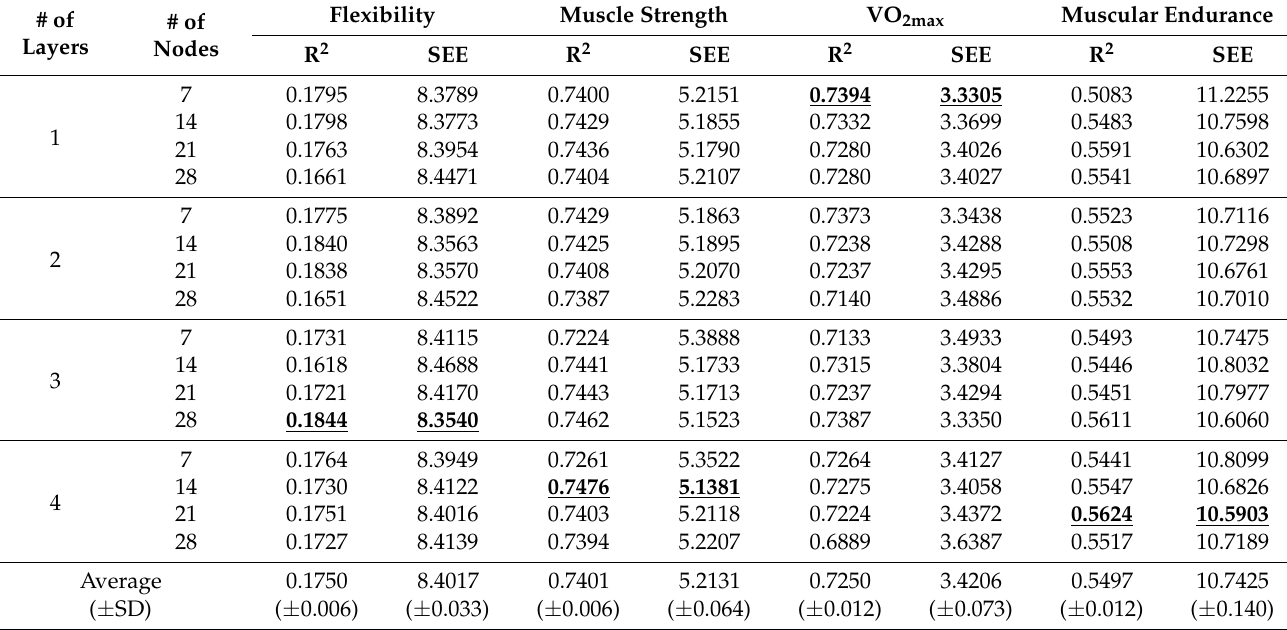
Table 2. Comparison of estimation accuracy according to hidden layer structures.